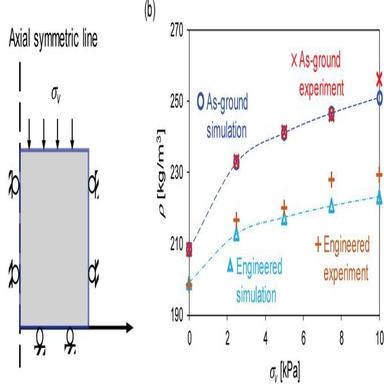
Numerical calibration process to determine the exponent β: (1) simulation of a suite of oedometer tests using a single axial symmetrical element model (a) with different input β; (2) calibration of β by finding the best match of bulk density ρb evolution under different level of compression σv between numerical prediction and experimental measurements using least-square method (b).